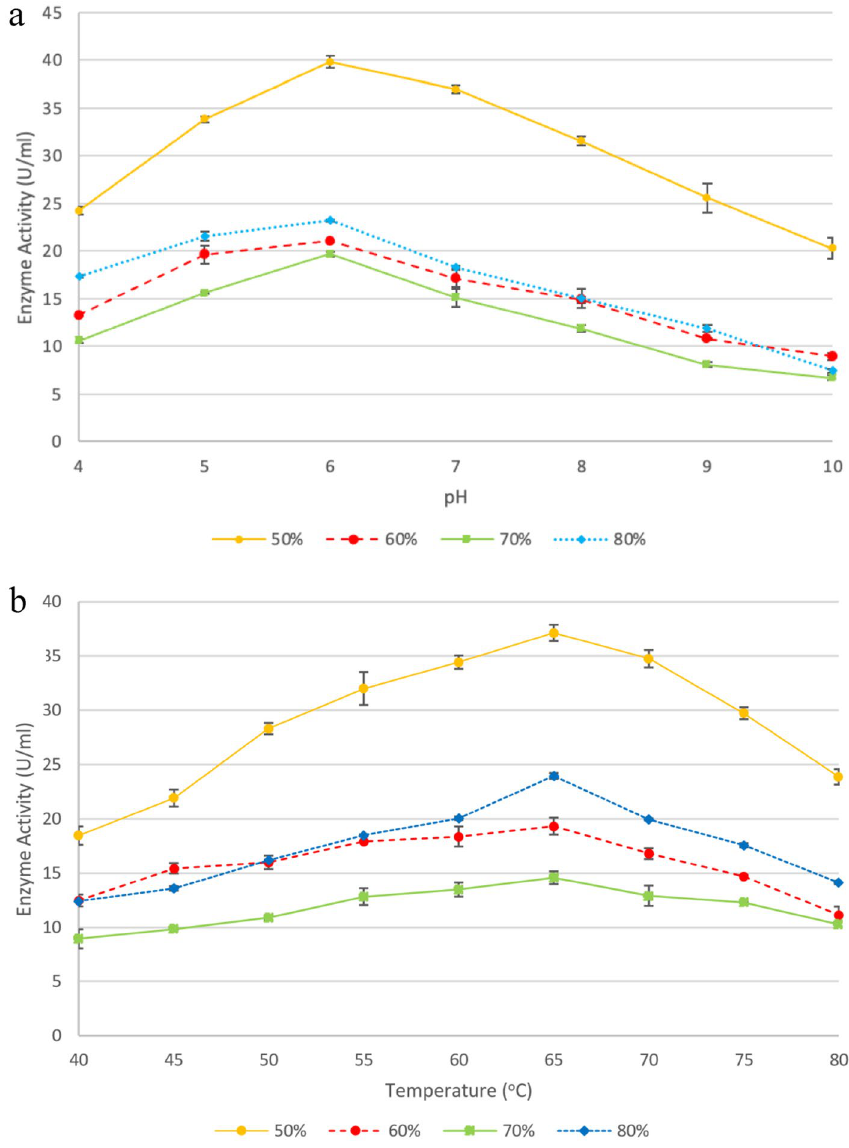
Figure 8. Effect of pH ( a ) and temperature ( b ) on the activity of purified xylanases (50%, 60%, 70%, and 80% ammonium sulphate fractions). Data points represent the means ± SD (n =